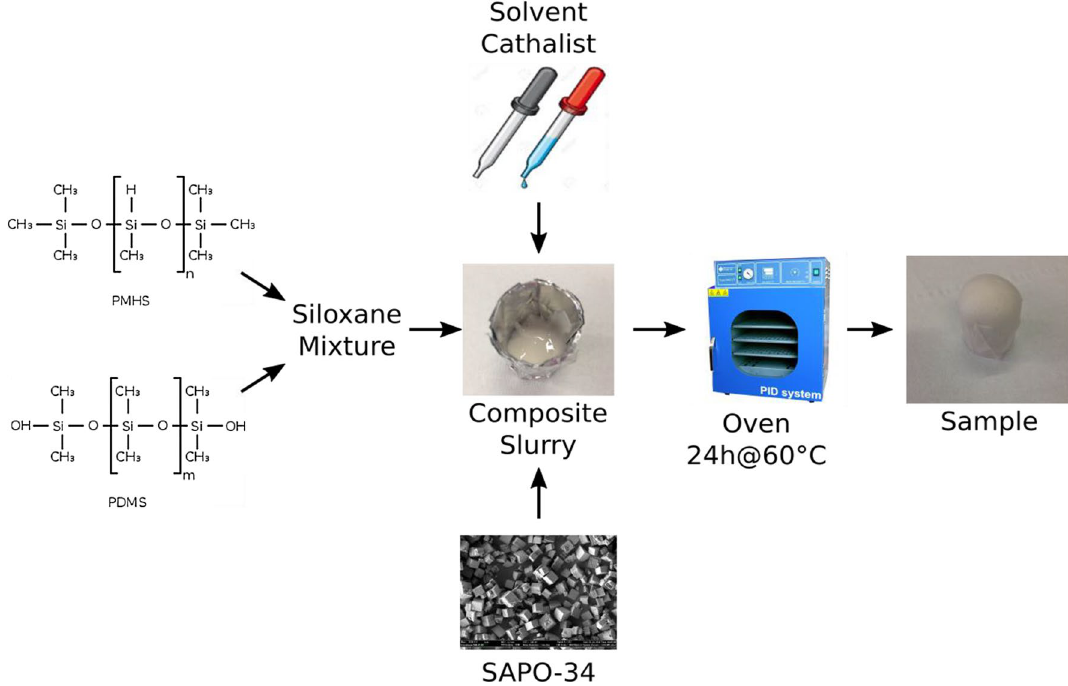
Fig. 1 Scheme of the composite foam